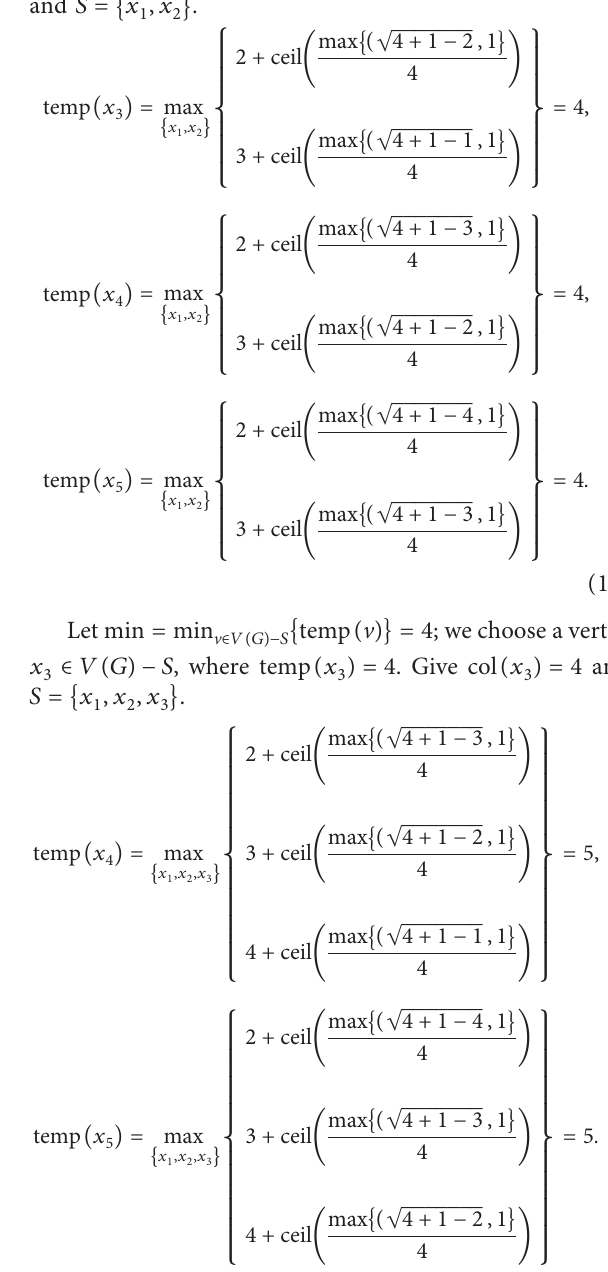
Figure 1: The radio mean square number of P ( P 115 ) �